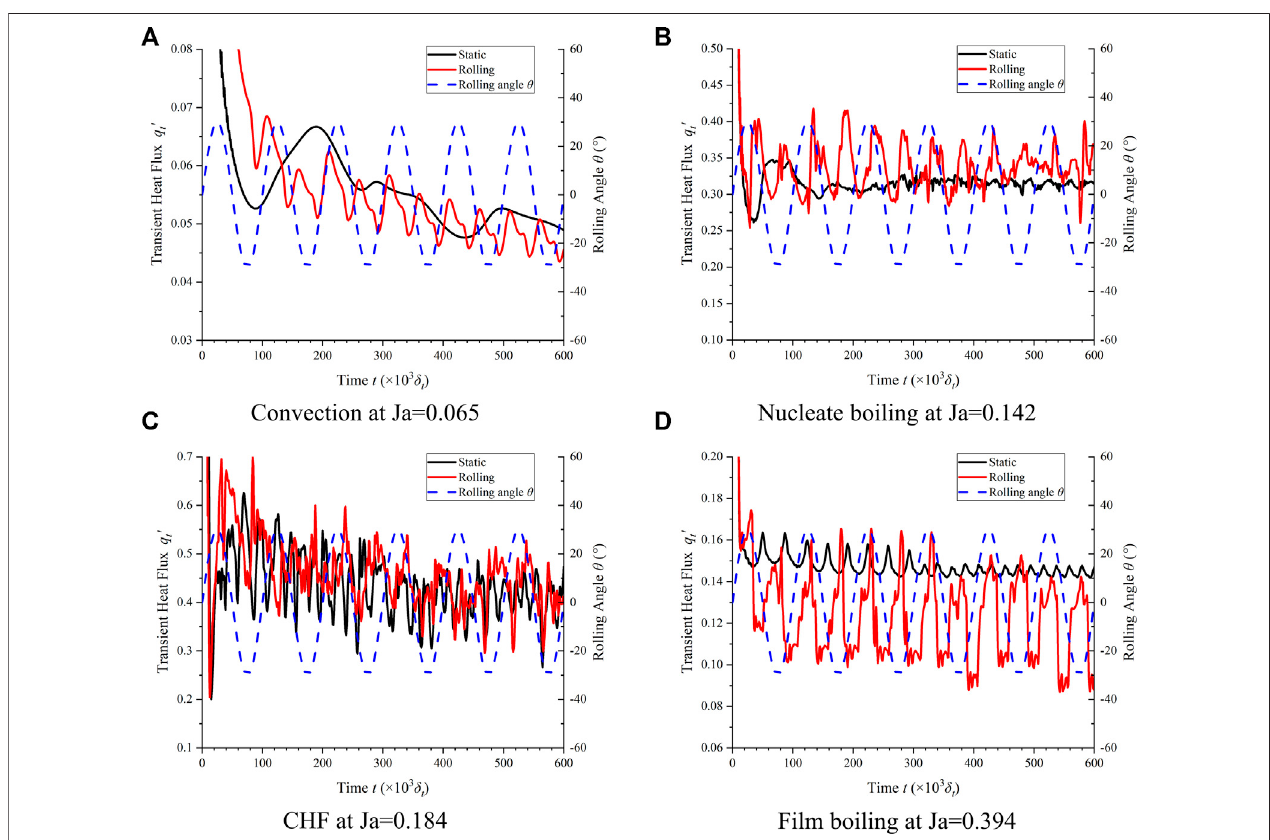
FIGURE 4 | Transient heat fl ux during the rolling period at different pool boiling